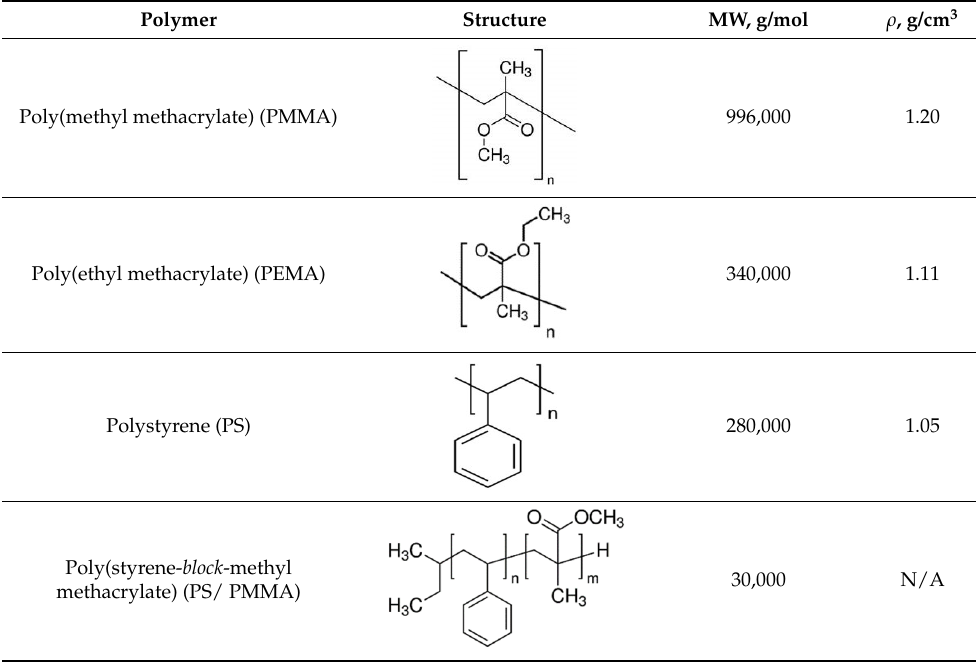
Table 2. Structure, molecular weight, and density of the polymers used.